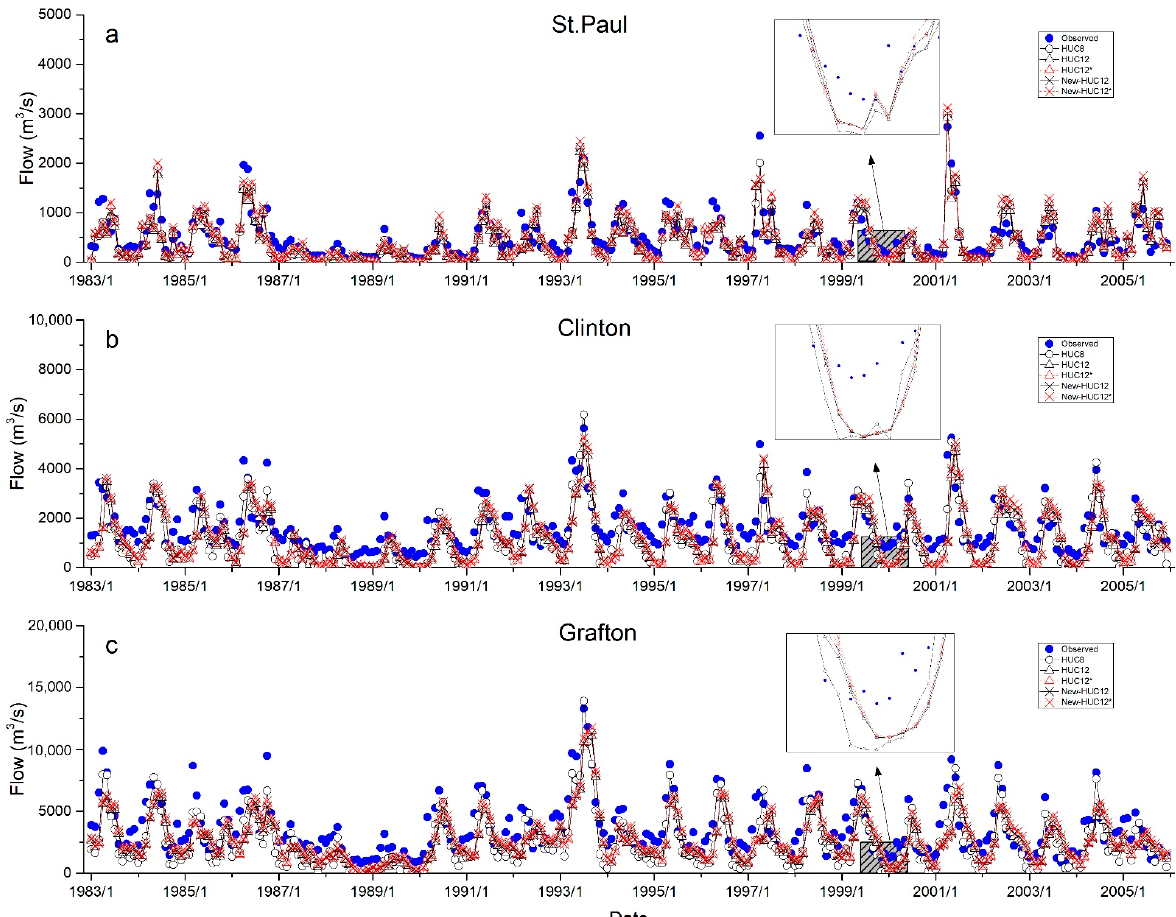
Figure 4. Simulated versus observed monthly streamflow during 1983 to 2005 at three gauge sites: ( a ) St. Paul, ( b ) Clinton and ( c ) Grafton.